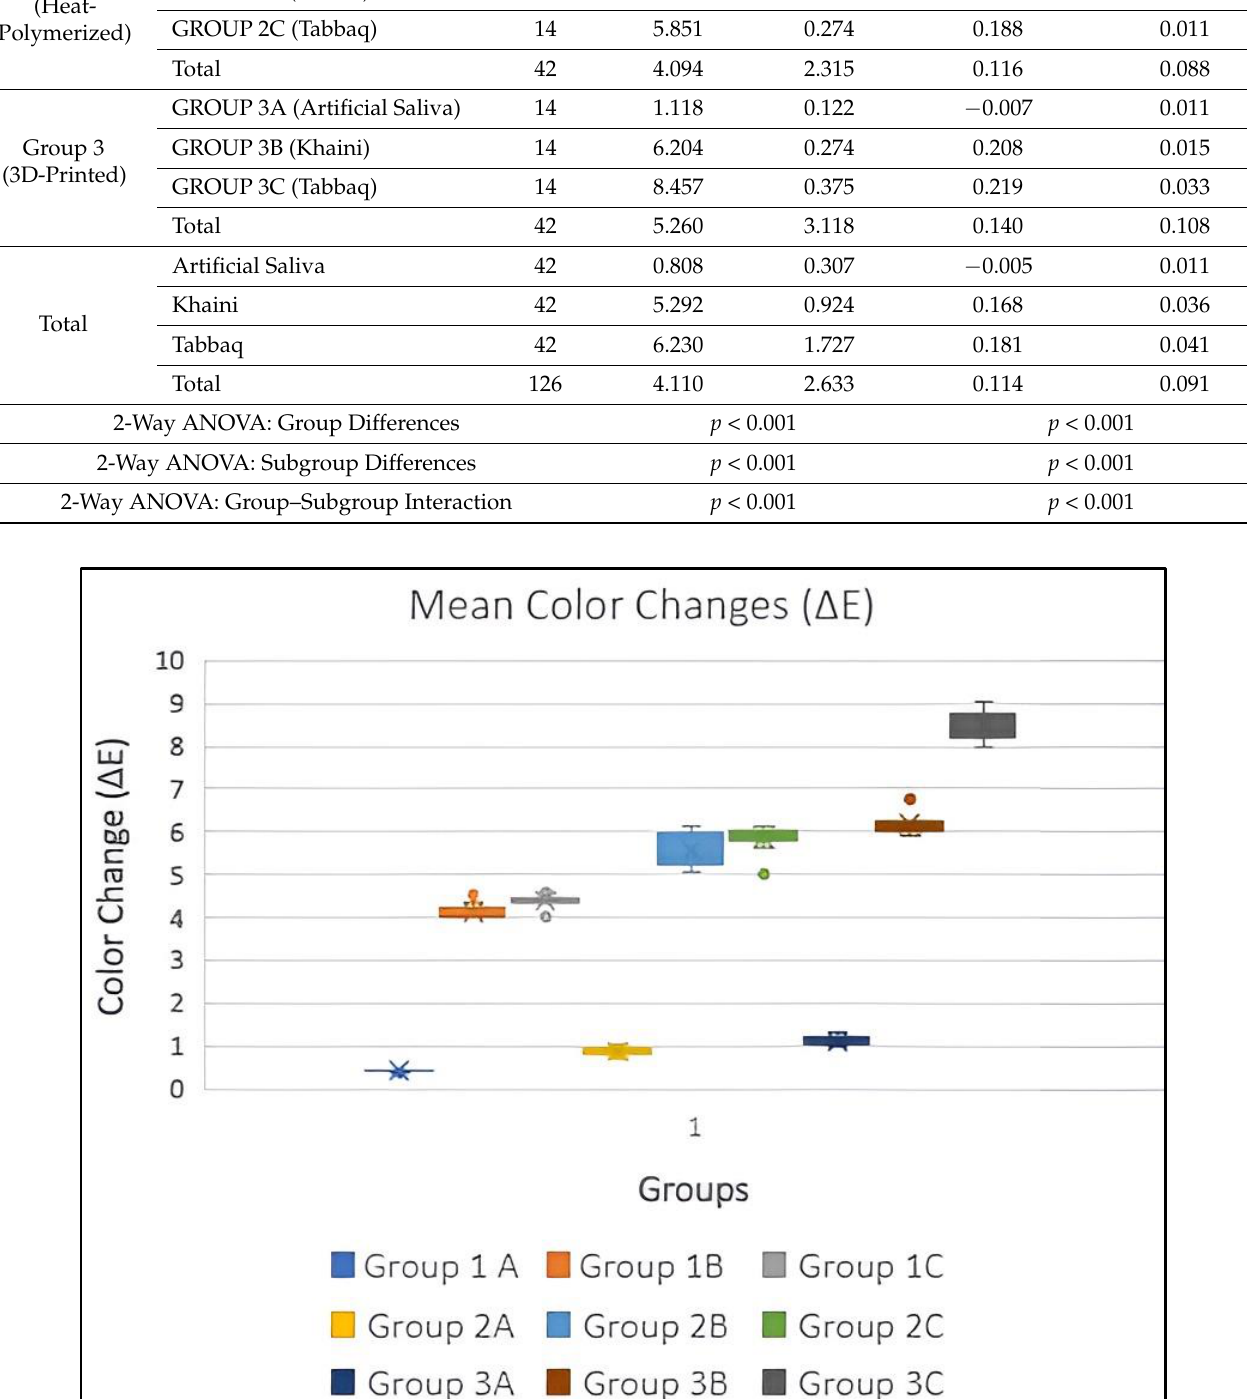
Figure 8. Mean surface roughness changes (ΔRa) in all groups. The Bonferroni post hoc test was used to check differences between color change (ΔE) and surface roughness change (ΔRa) between groups and subgroups, as shown in Tables